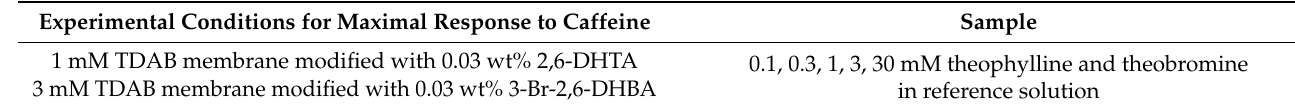
Table 2. Experimental conditions and compositions of sample solutions used in Step 3.